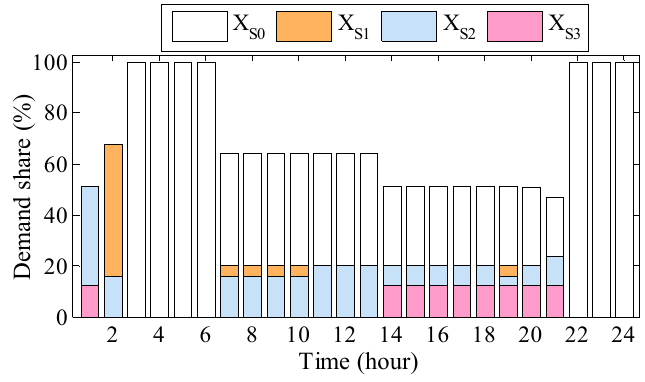
Figure 14. EVs’ demand share during the whole day.